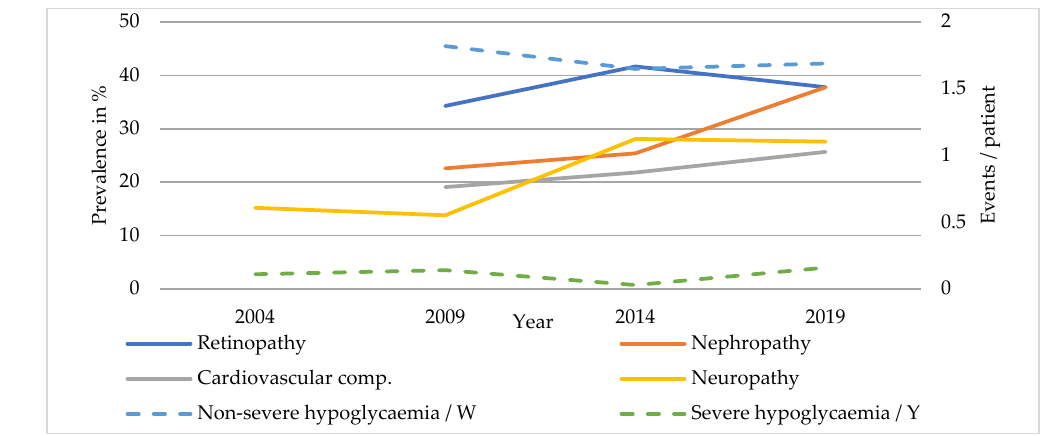
Figure 1. Diabetic complications of patients with T1DM in SC.